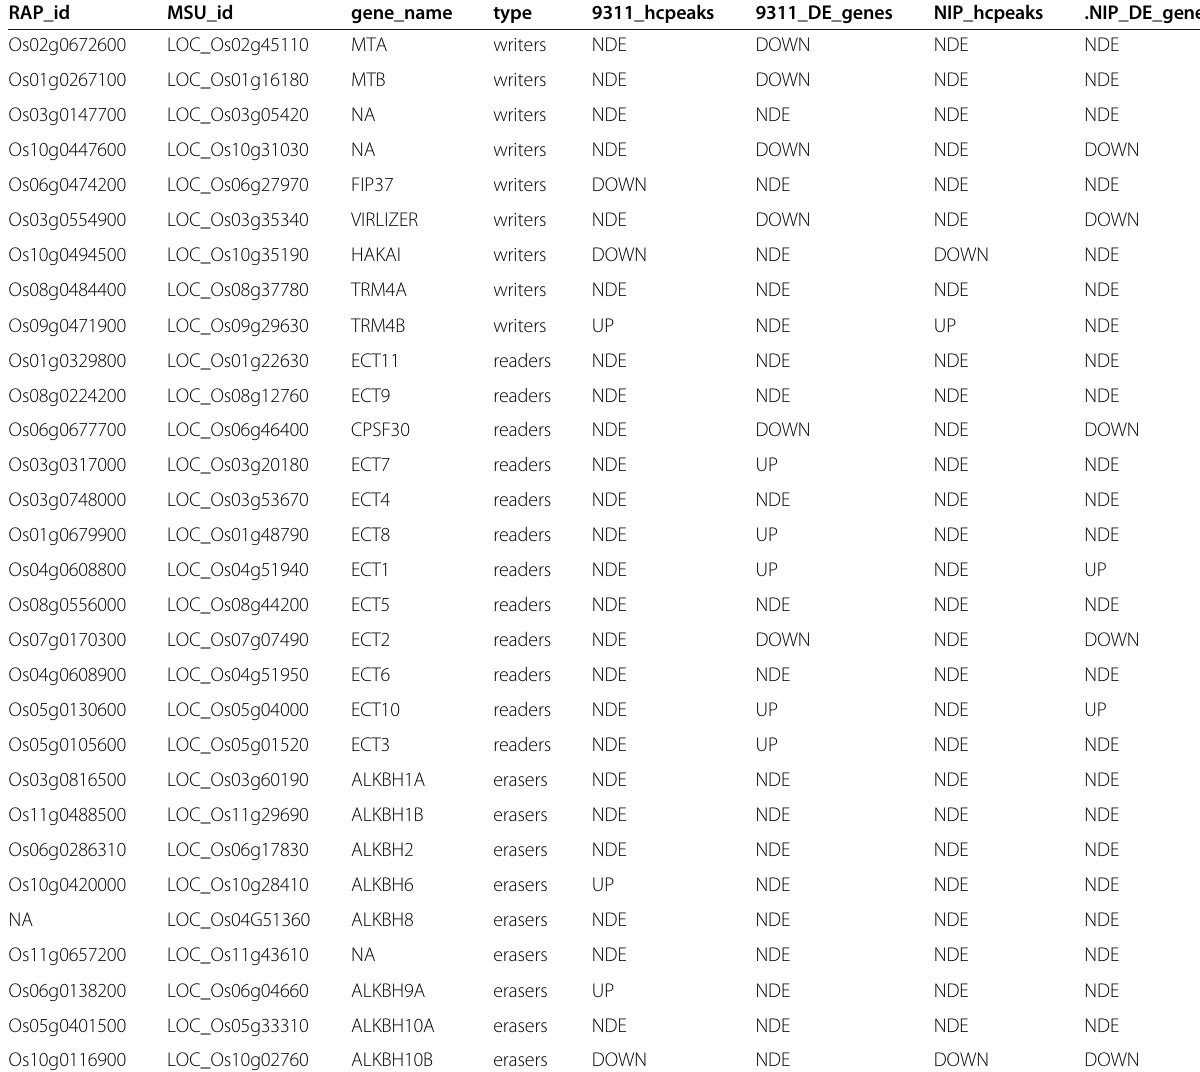
Table 1 RNA methylation related genes in rice. “ UP ” means this gene is overlapping with up hcpeaks or in up genes when comparing Cd to CKvice versa. “ NDE ” means this gene is not in differential hcpeaks or DE